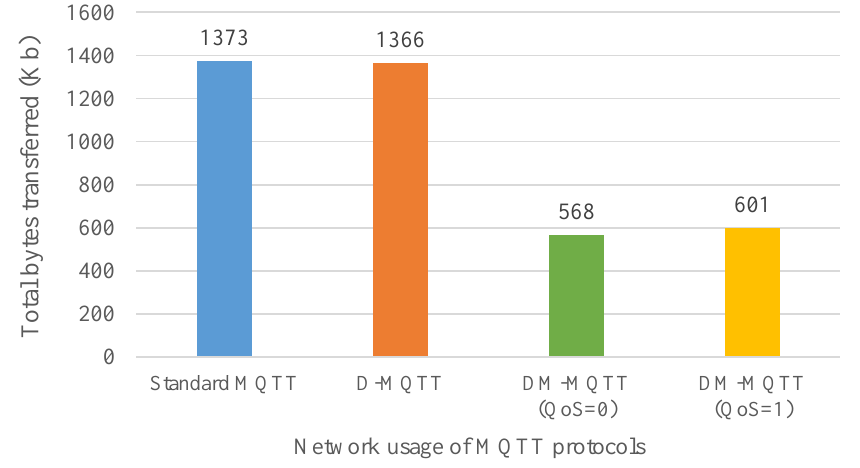
Figure 9. The total number of bytes transferred for each MQTT protocol.